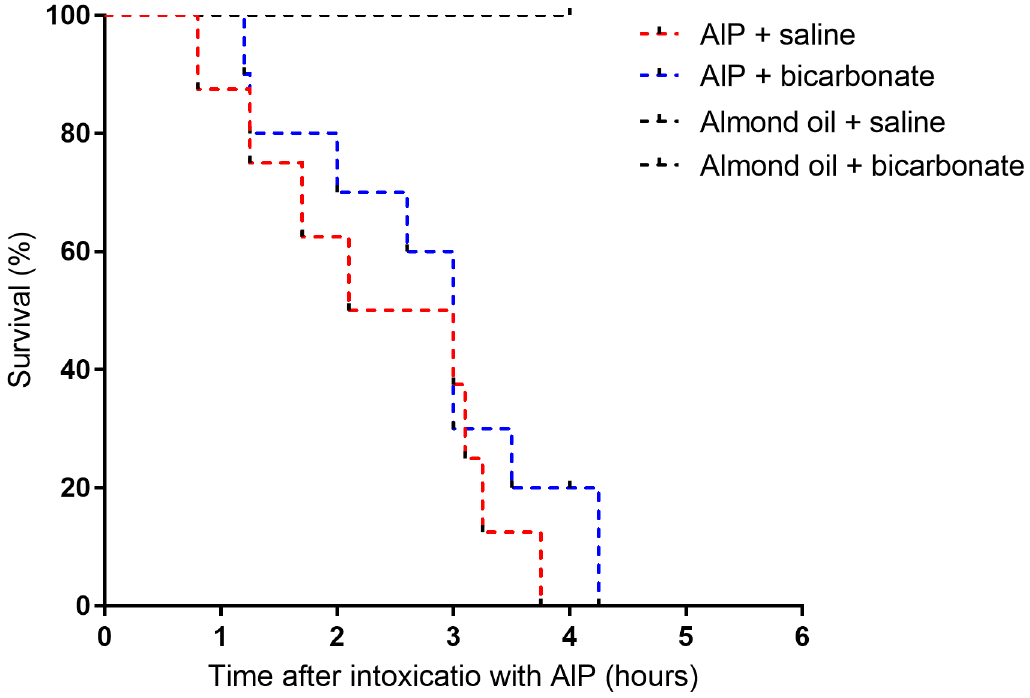
Fig 5. Effect of sodium bicarbonate administration on mortality of aluminum phosphide (AlP) in rats. Kaplan-Meier graph indicates the survival rate of rats intoxicated with AlP with concurrent administration of either isotonic sodium bicarbonate or